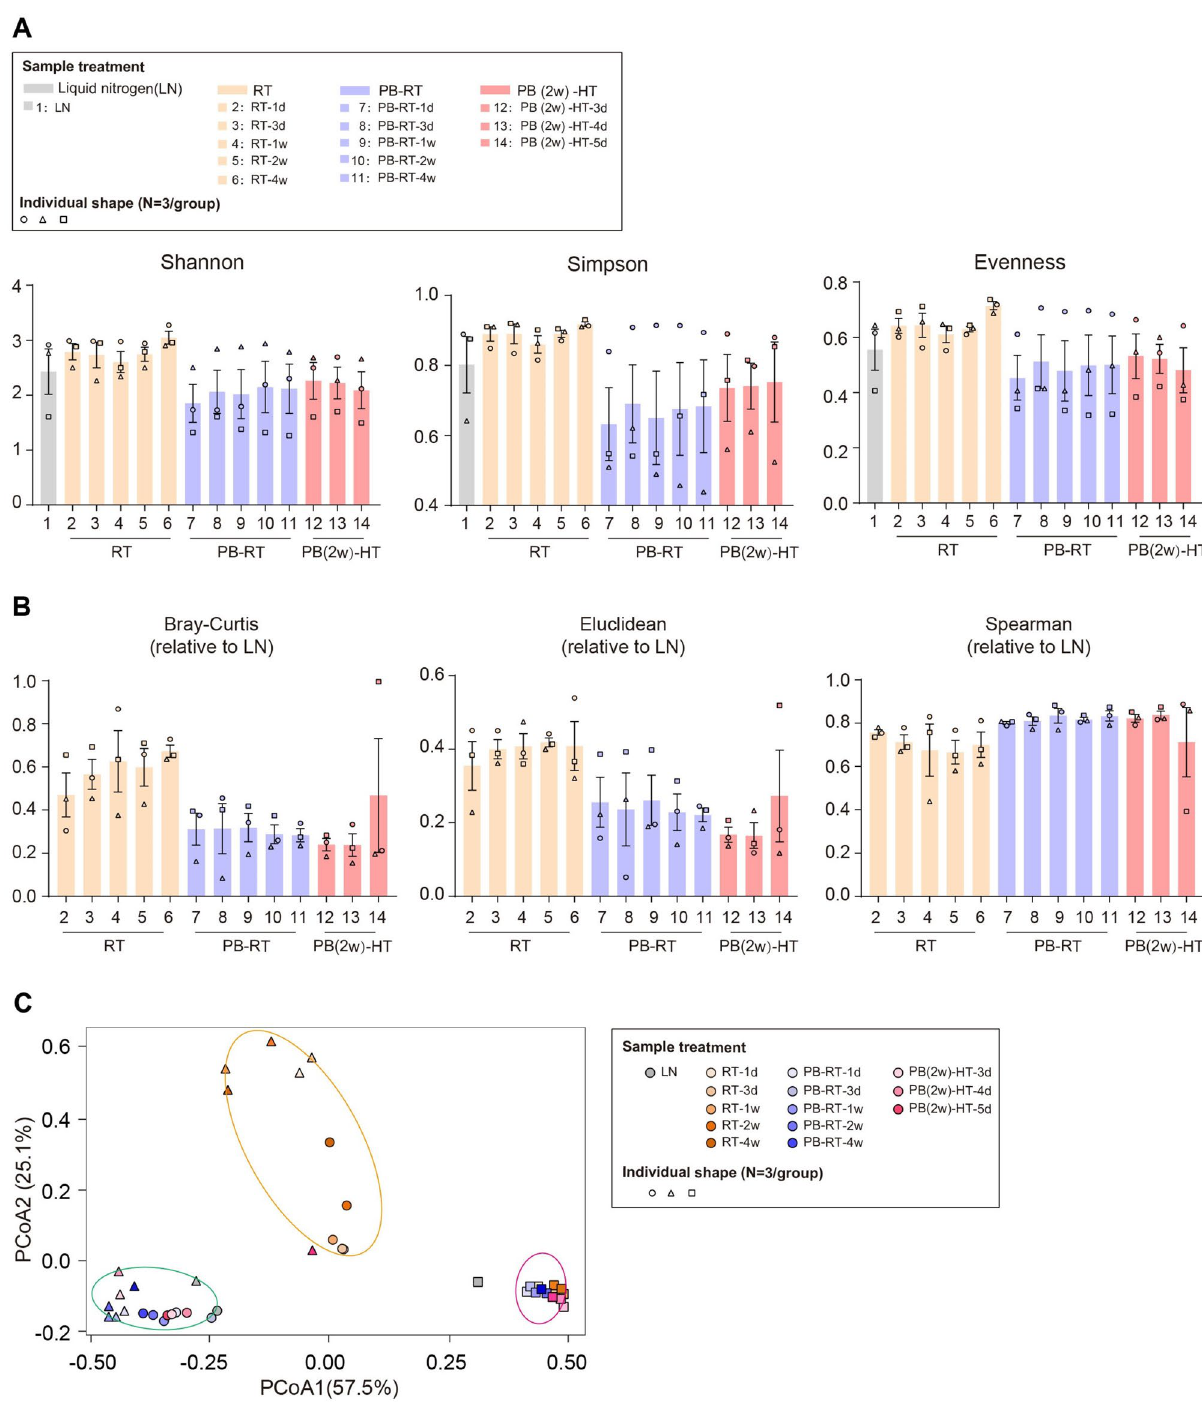
Figure 2. Stability analysis of human fecal microbiota preserved by self-made preservation buffer (PB). ( A ) Shannon, Simpson and Evenness indices of microbiota in fecal samples treated under liquid nitrogen (LN), room temperature (RT), PB buffer, or PB-high temperature preservation. ( B ) Distance and correlation analysis of each group compared with LN group based on Bray Curtis, Euclidean and Spearman coefficient. ( C ) The Principal Coordinate Analysis (PCoA) of fecal microbiome under different conditions, based on the Bray– Curtis dissimilarity index. N = 3 volunteers/group, each point shape represents an